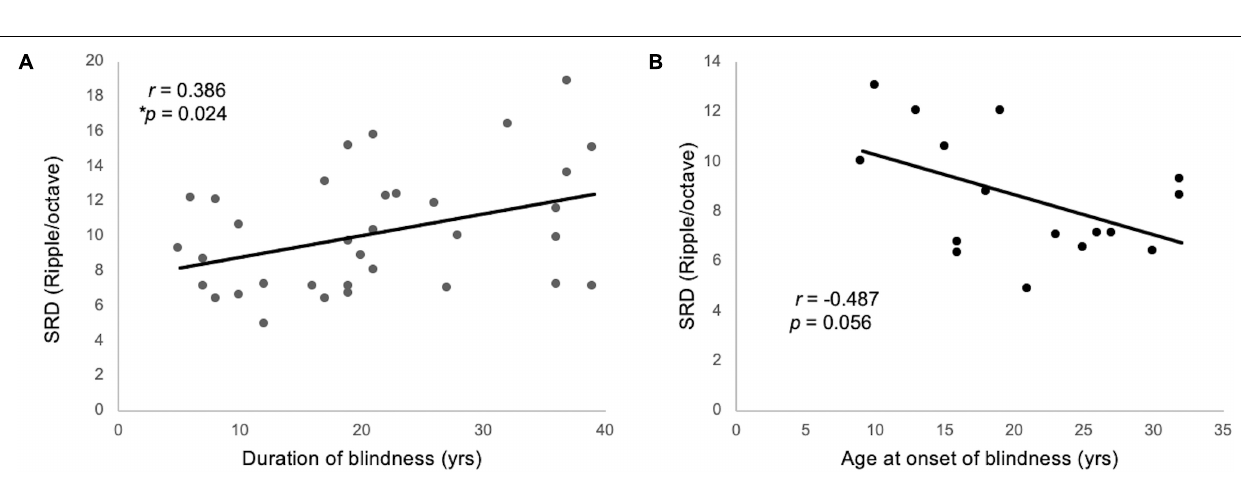
FIGURE 3 | (A) The SRD threshold was significantly correlated with the duration blindness duration among 35 individuals from the EB and LB groups. (B) For 16 LB subjects, SRD thresholds showed a trend toward significance in the correlation with the ages of onset of blindness.